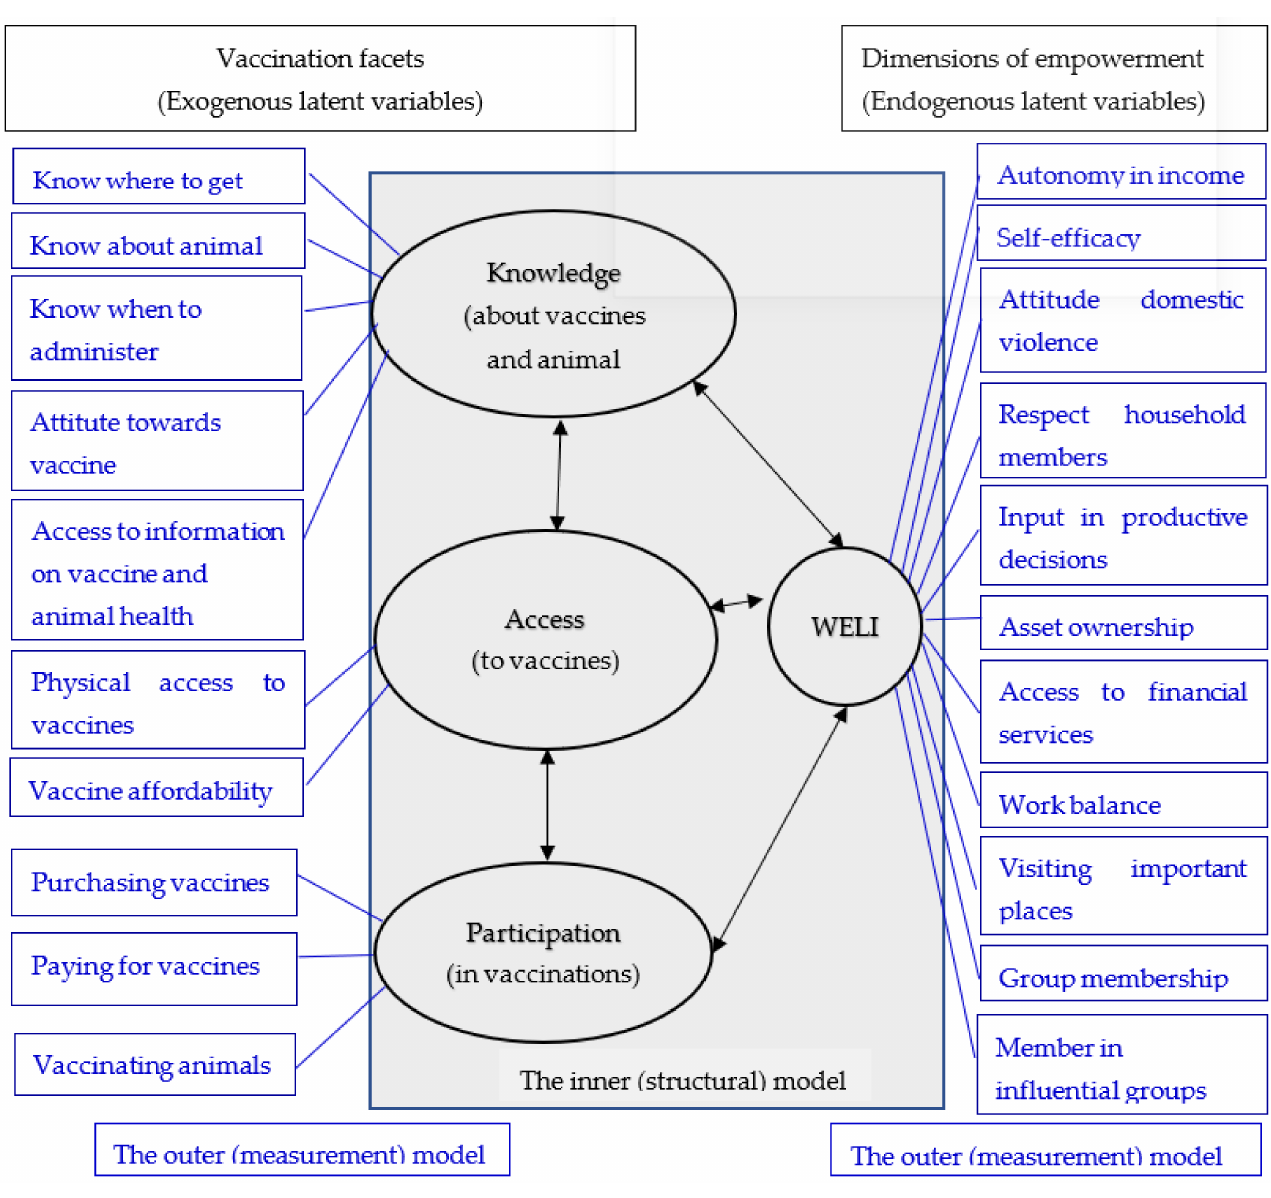
Figure 2. Conceptual model for evaluating the relationship between empowerment dimensions and vaccination